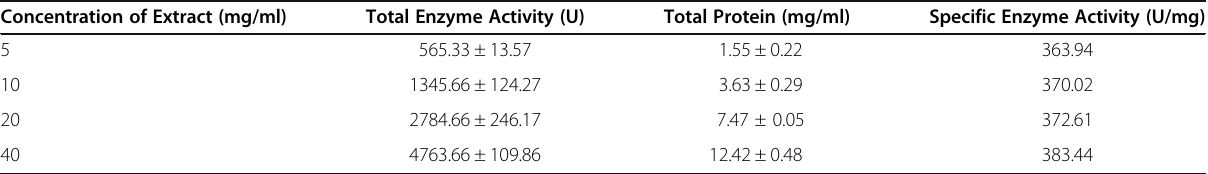
Table 1 Proteolytic activity of Cinnamomum cappara leaf extract Concentration of Extract (mg/ml)